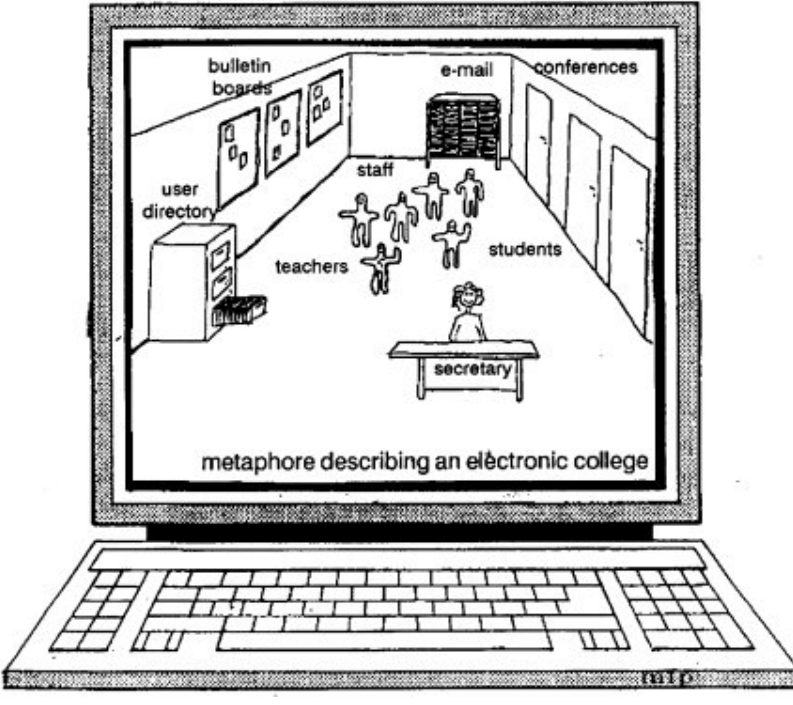
The first generation system